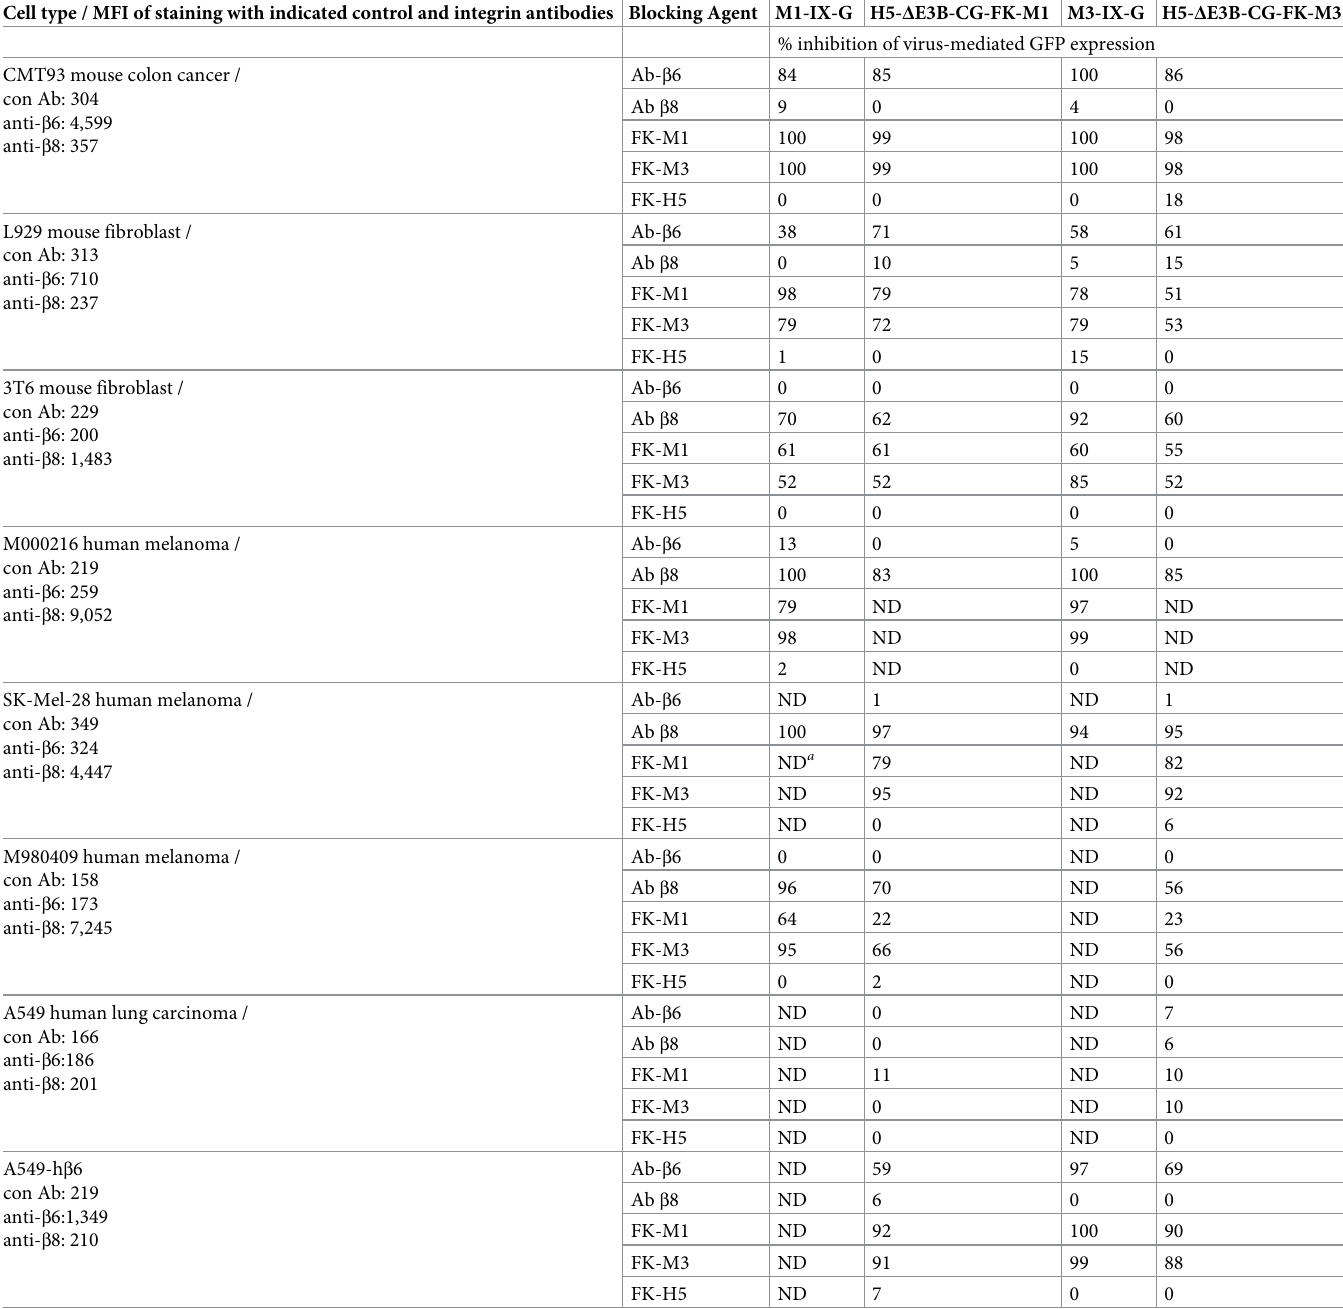
% inhibition of virus-mediated GFP expression